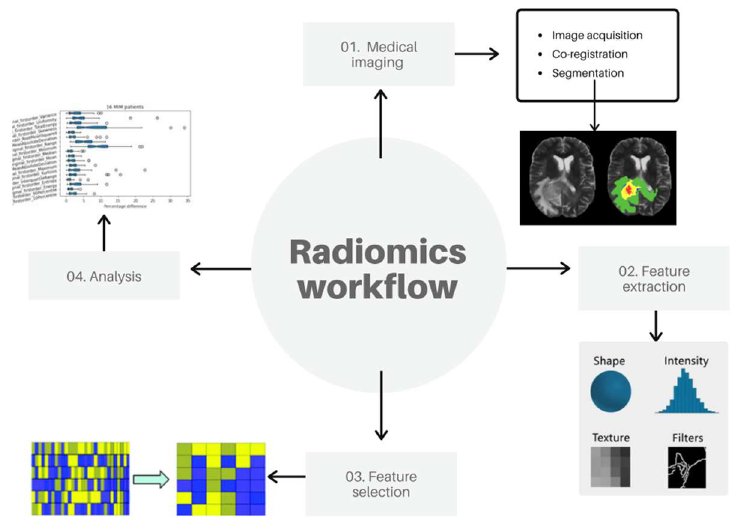
Figure 1. An overview of the study workflow.